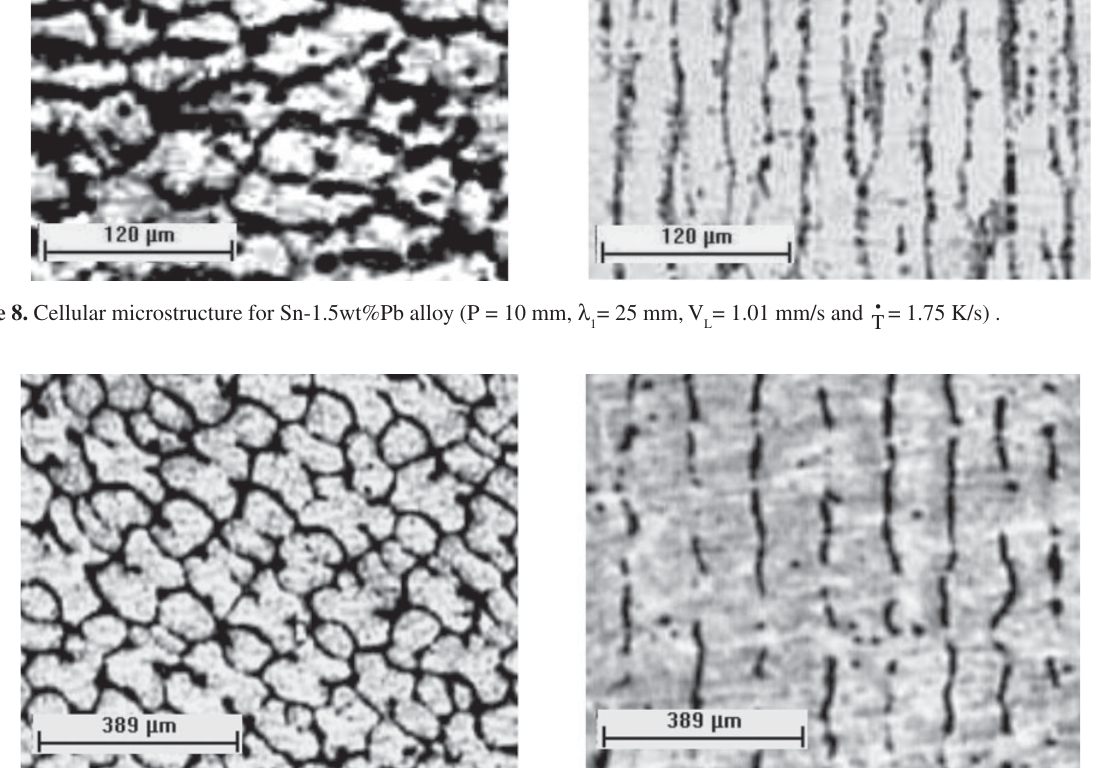
= 95 mm, V = 0.38 mm/s and • T = 0.24 1 L